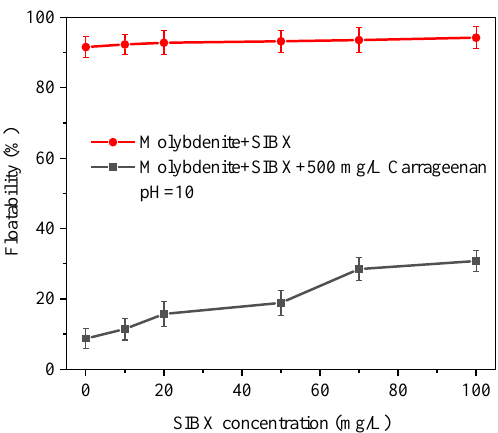
Figure 5. Floatability of molybdenite as a function of SIBX concentration.